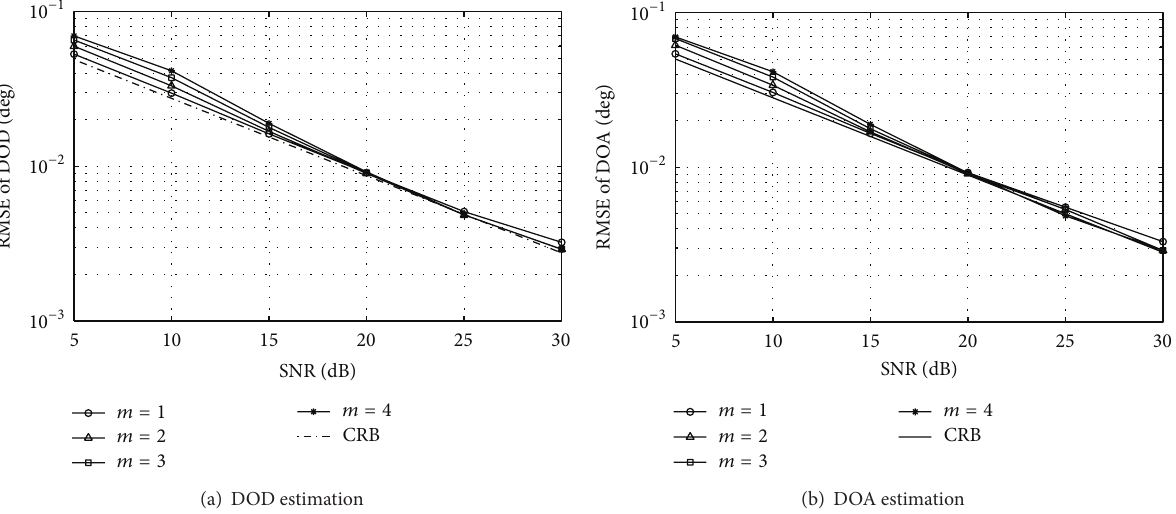
Figure 1: RMSEs of angle estimation against input SNR.